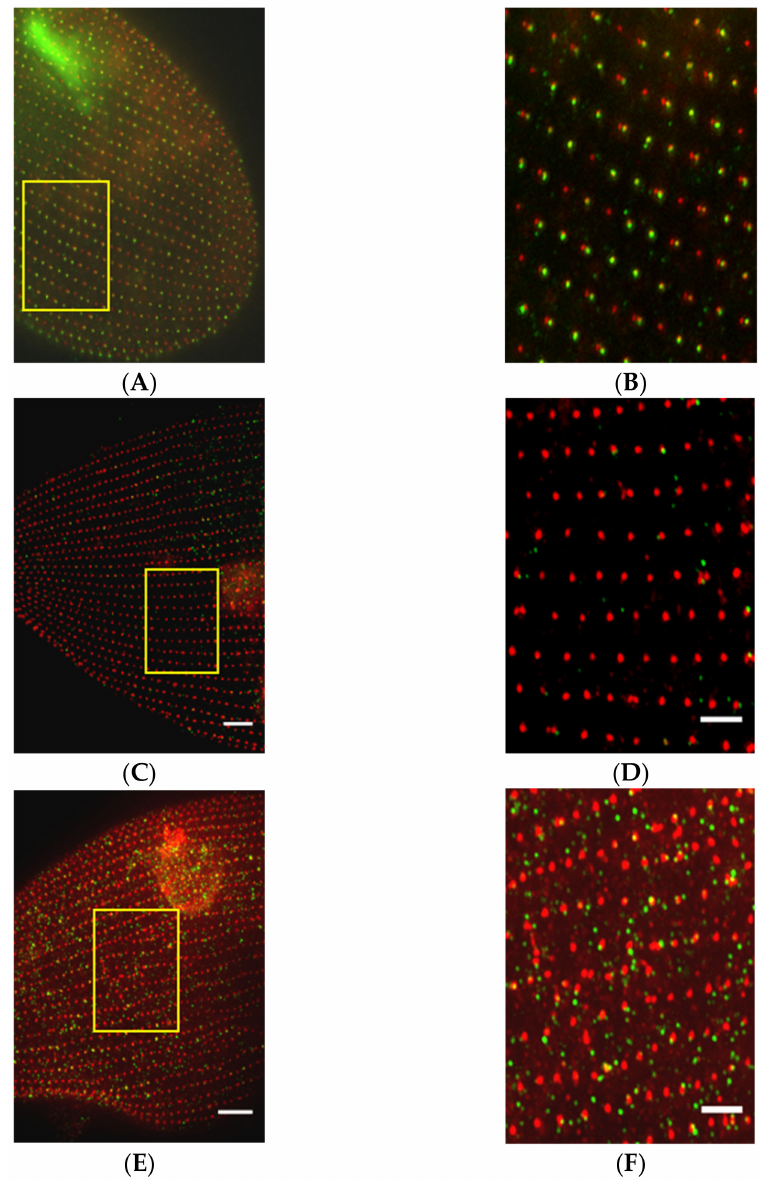
Figure 14. Depletion of MKS5 affects the localization of B9D2 protein in TZ of the basal body. All cells were treated with anti- Tetrahymena centrin and anti-GFP antibody to visualize the basal body units (red) and GFP-B9D2 protein in the cell. In all the images, the yellow box highlighted area is enlarged to show the basal body rows and GFP localization in the GFP-B9D2 expressing cell. Panels A and B show the basal body row alignment and GFP-B9D2 localization in the control cell. In the control cell, basal body (red) rows remain straight with GFP-B9D2 protein localization at the TZ of the basal body in a single basal body unit. In two basal body units, only the posterior basal body has the signal for GFP-B9D2 protein. Panels C and D show the basal body row alignment and GFP-B9D2 protein localization in the MKS5 depleted cell. In the MKS5 depleted cell, basal body rows remain straight like the control cell but GFP-B9D2 localization shows a remarkable difference compared to the control cell. Both the single basal body and the posterior basal body of the two basal body unit lack the localization of B9D2 protein in the MKS5 depleted cell. Panels E and F show the basal body row misalignment and localization of B9D2 protein in the MKS3 depleted cell. In the MKS3 depleted cells, cell basal body rows are misaligned and GFP-B9D2 protein shows very dispersed and diffused localization. Scale bars are 10 µ m in ( A , C , E ) and 3 µ m in ( B , D , F ). Reproduced with permission from